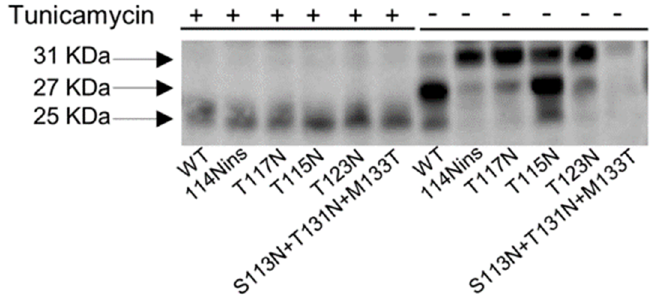
Figure 3. Immunoblotting of Strep-tagged HBsAg in presence of (referred as “ + ” in the figure) and in absence of (referred as “-” in the figure) tunicamycin treatment. Huh7 cells were transfected with a plasmid encoding wt and mutated strep-tagged HBsAg. After 6 h, the glycosylation inhibitor tunicamycin was added at concentration of 1 µ g / mL. After 48 h, cell lysates were subjected to SDS-polyacrylamide gel electrophoresis and detected with antibodies targeting the Strep-tag portion of strep-tagged HBsAg. The 25 KDa band corresponds to the un-glycosylated form of strep-tagged HBsAg, the 28 KDa band to the HBsAg glycosylated at the classical N-linked glycosylation site at position 146, while the 31 KDa band corresponds to the HBsAg form glycosylated at the position 146 and at the novel identified N-linked glycosylation sites.